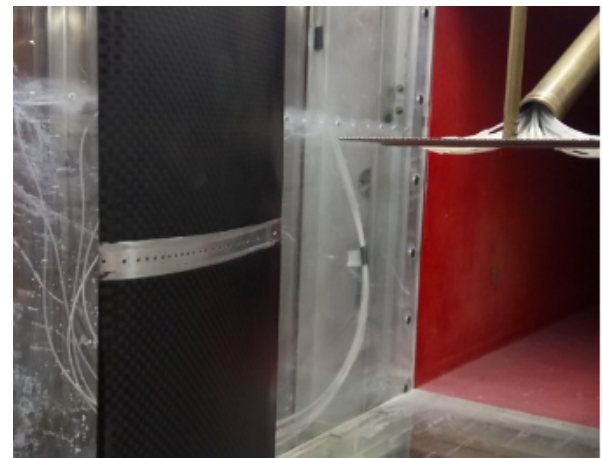
Figure 3. The experimental setup used to measure the blade polars in the DTU red wind tunnel. The pressure loop is at the midspan of the blade sectional model, and the wake rake is visible downstream.